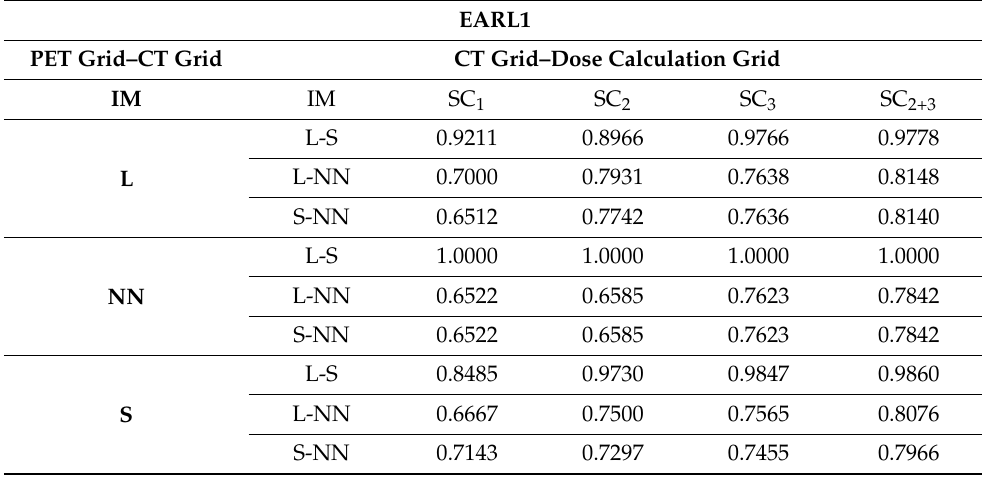
Table 3. Shape coefficients obtained for the EARL1 reconstruction when going from the CT grid to the dose calculation grid.